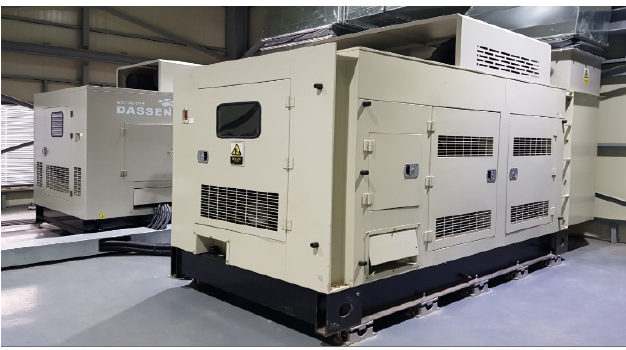
Figure 7. Test generator engine of the testbed. Table 3. Hybrid testbed and generator engine specifications.